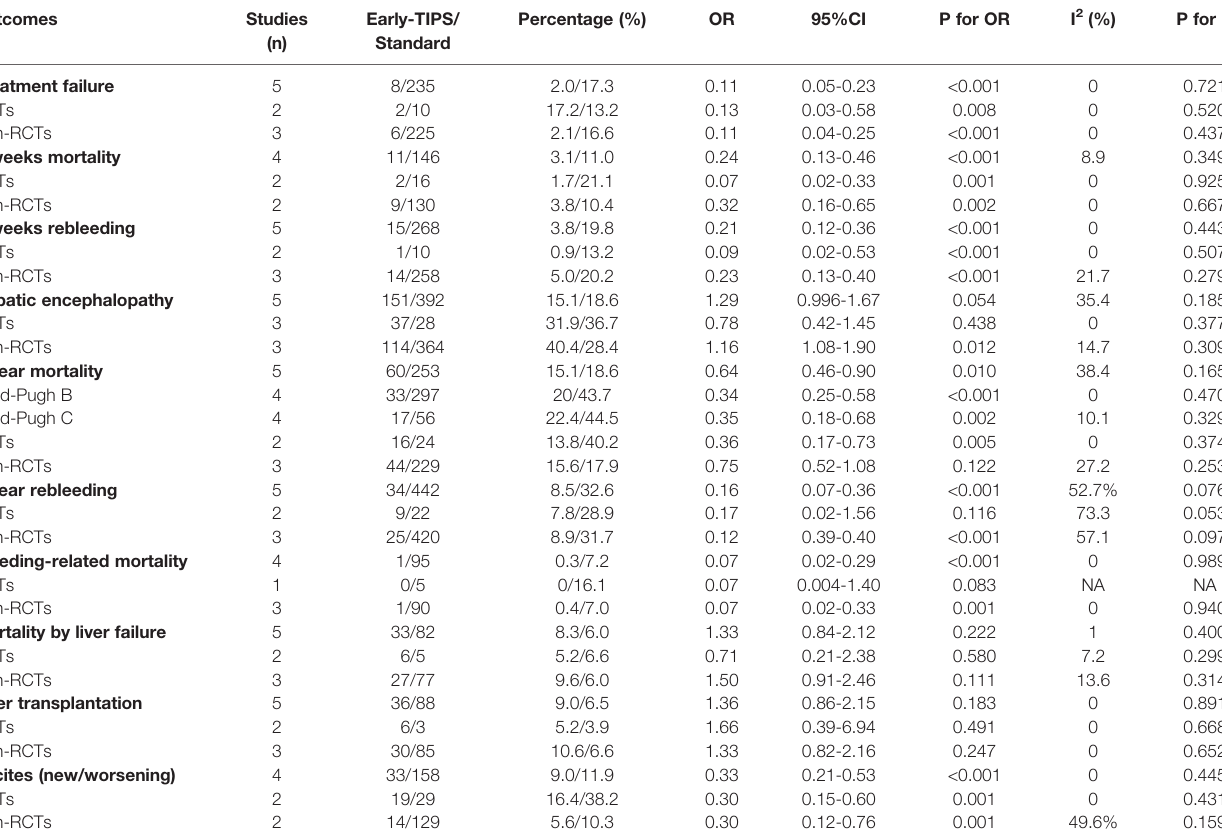
TABLE 2 | The results of subgroup analysis in all